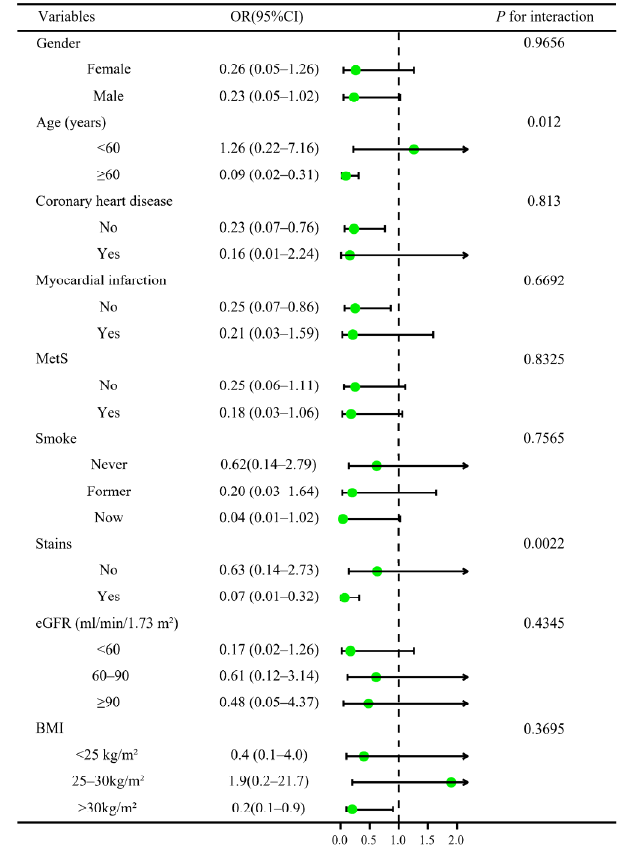
Figure 3. Forest plots of stratified analyses of atherogenic index of plasma and incident heart failure. Age, gender, BMI, education level, smoke, coronary heart disease, heart attack, angina, stroke, MetS, diabetes, eGFR, hypertension, glucose, HbA1c, ALT, albumin, globulin, creatinine, blood urea nitrogen, HDL cholesterol, hs-CRP, statins use, diabetes medication, and antihypertensive medication were all adjusted except the stratification variable itself.